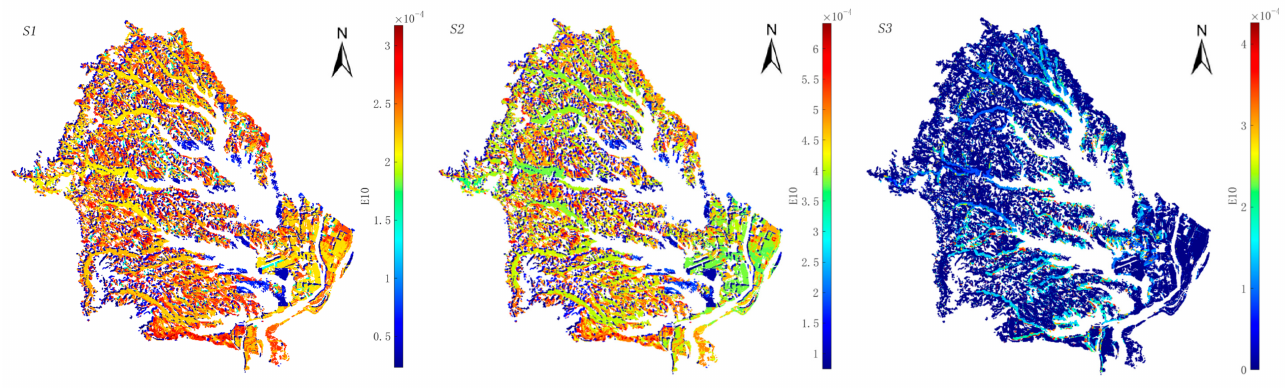
Figure 12. Spatial distribution of D9 under different scenarios. S1: halving fertilization every year; S2: fallow every other year; S3: returning agricultural land to forest.